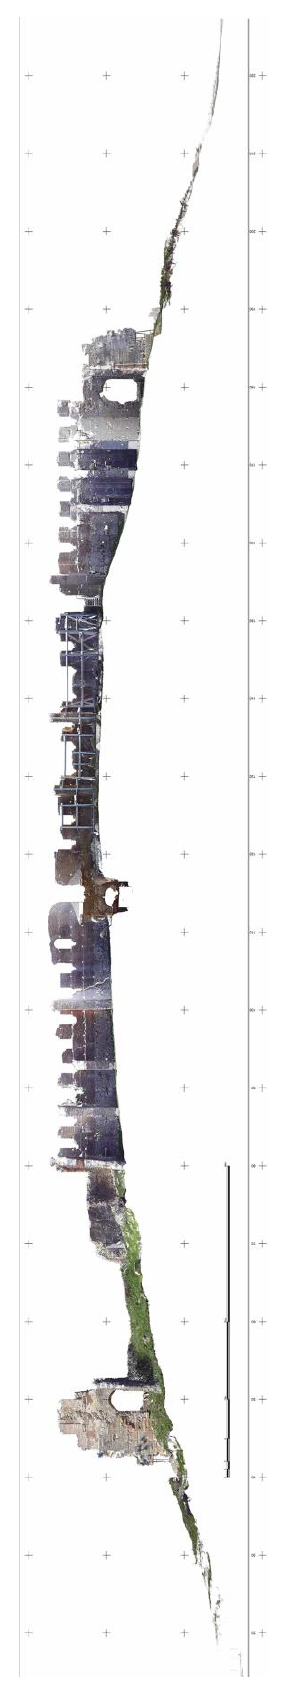
Figure 11. Unrolled elevation plan of the perimeter of the